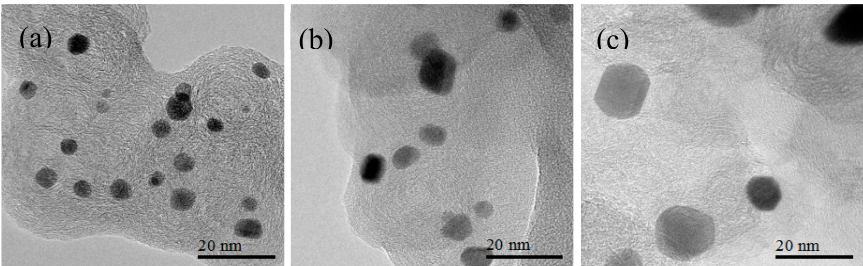
Figure 11. TEM bright-field images of as prepared ( a ) 4.9 nm ( b ) 8.1 nm and ( c ) 14.8 nm Pt 3 Co cathode catalysts supported on carbon (Scale bar = 20 nm).